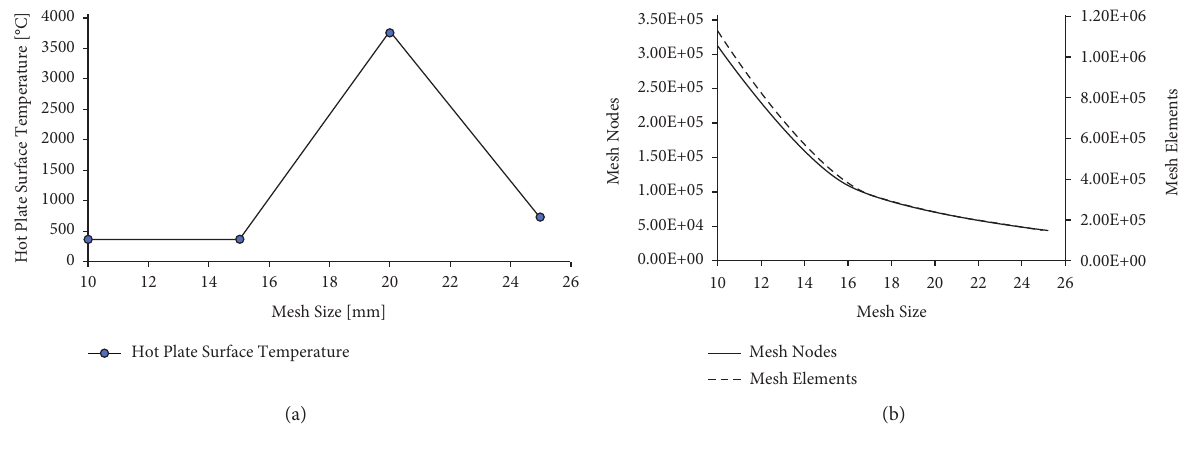
Figure 4: Grid independence test. Table 4: Hot plate surface temperature versus time.